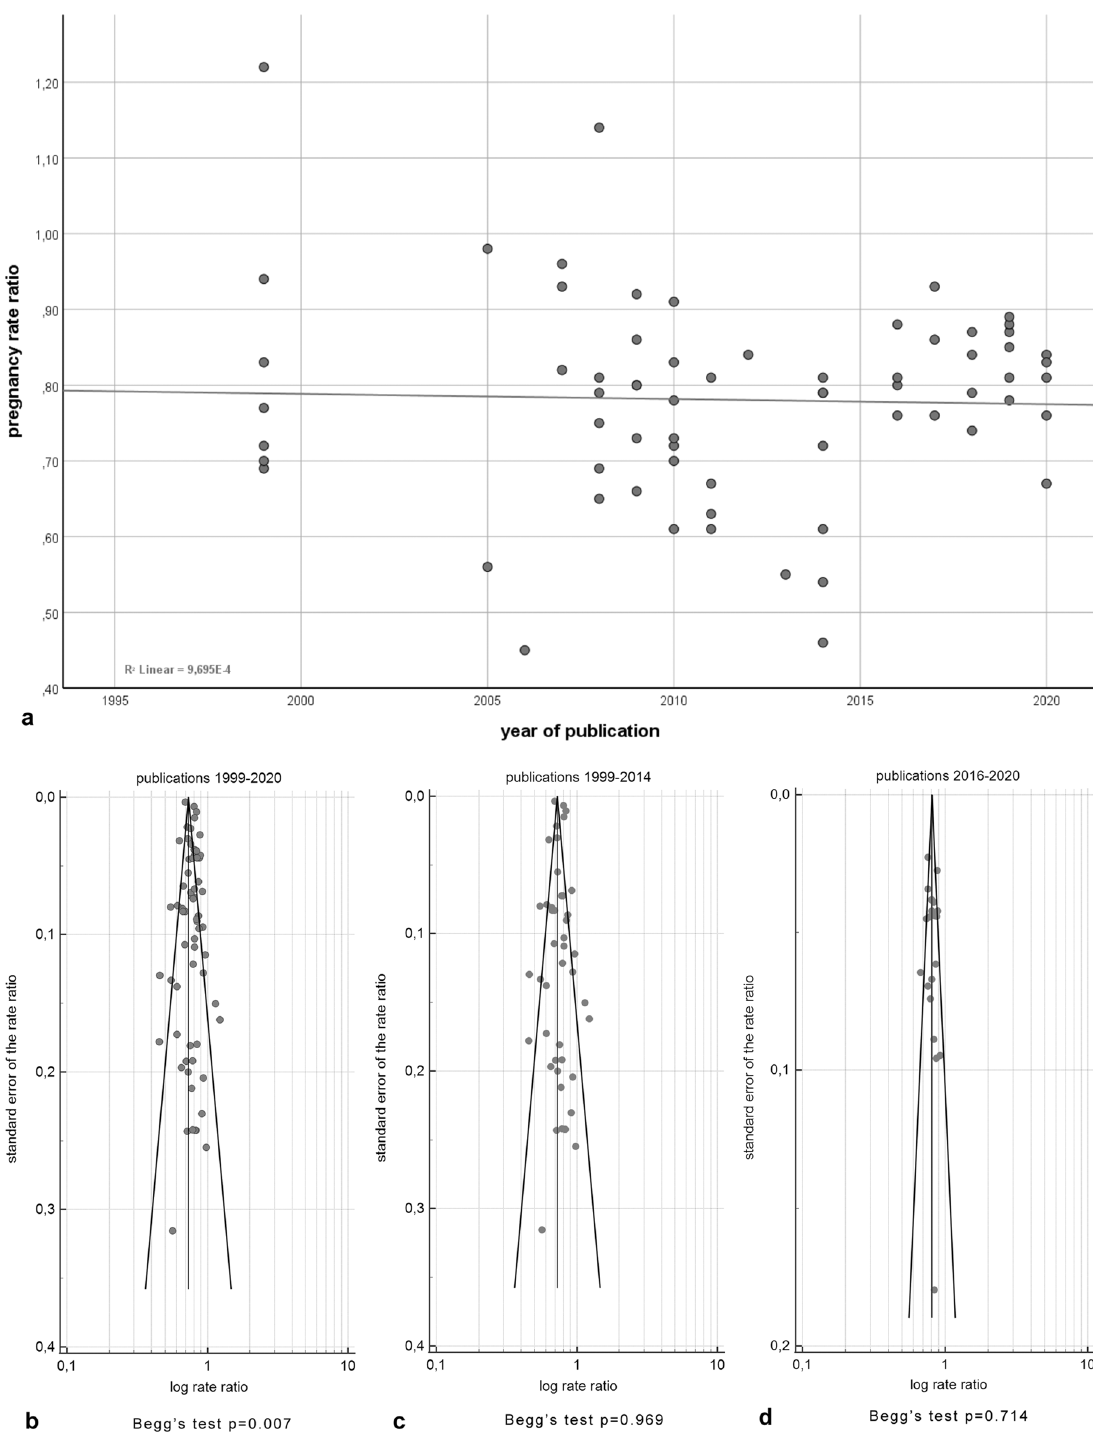
Figure 4. Pregnancy rate ratios in relation to the year of publication and funnel plots of studies evaluating publication bias in the reproductive success of bovine sperm after sex-sorting. ( a ) The pregnancy rate ratios show a high variation before 2015 whereas the data after 2015 reveal much less heterogeneity and an increased number of studies near the regression line. ( b ) The funnel plot of the studies published between 1999 and 2020 reveal asymmetry with outliers located besides the lines marking the 95% confidence limits. The Begg’s test reveals a significant p value of 0.007. ( c ) In the funnel plot of the studies between 1999 and 2015 there is no publication bias (p = 0.969, Begg’s test). ( d ) In the funnel plot of the publications between 2016 and 2020 the majority of values are within the 95% confidence limits and there is no publication bias (p = 0.714, Begg’s